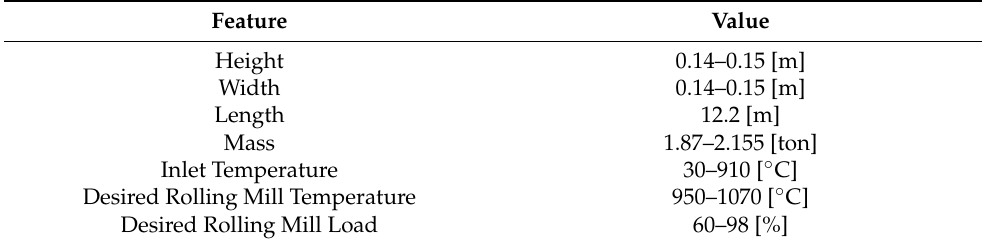
Table 1. Billet features.